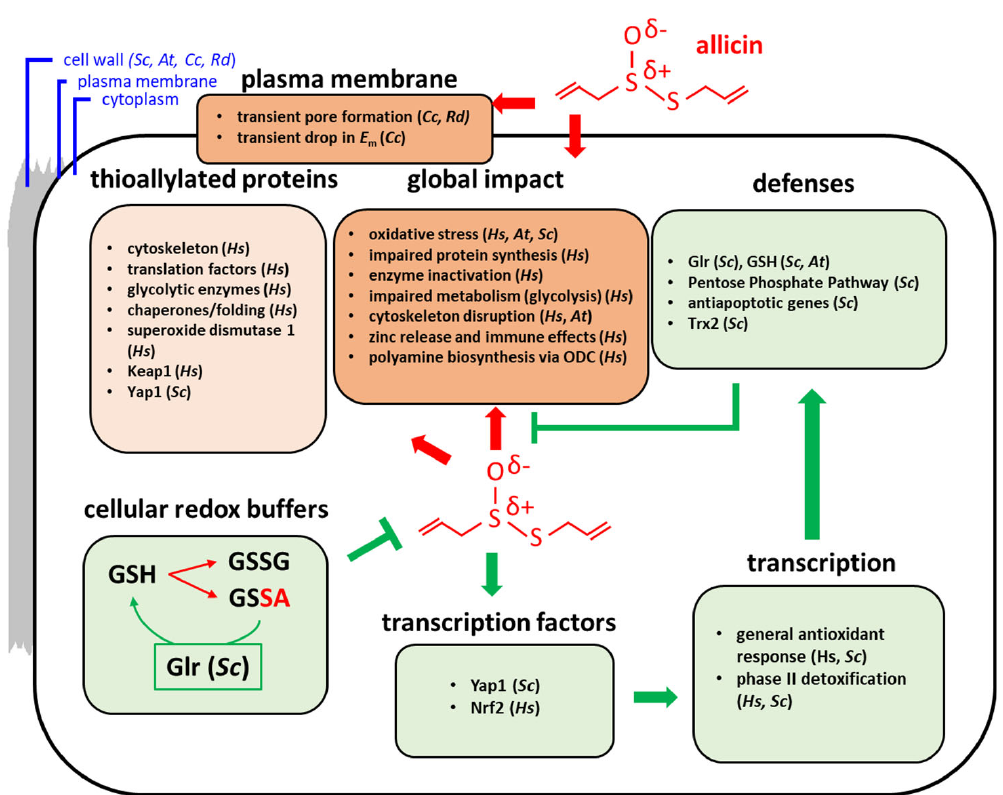
Figure 5. Summary of some of the effects of allicin on eukaryotic cells. Selected proteins are directly S ‐ thioallylated and their biochemical function is thus altered (in most cases inhibition). This manifests itself in a general oxidative stress response, changes in metabolism and the cytoskeleton, an altered immune response and an influence on polyamine metabolism. A direct influence on cell membrane integrity can also be observed. At the same time, cells also respond to allicin exposure, for example through redox ‐ sensitive transcription factors whose activity can be stimulated by allicin. Typical factors are the Nrf2 ‐ Keap1 system in mammals or the Yap1 transcription factor in yeast. These lead to the activation of protective mechanisms against oxidative stress. Various defense mechanisms are subsequently activated, with GSH synthesis being of particular importance. Associated with this is the Pentose Phosphate Pathway, in heterotrophic organisms the most important source of NADPH, the electron donor for glutathione reductase (Glr, GR). However, the expression of anti-apoptotic genes is also significant for protection against allicin, as is the phytohormone jasmonic acid in plants. Thioredoxins, especially Trx2, also seem to play a subordinate role, and their contribution is not as marked as that of the glutathione system. At = Arabidopsis thaliana , Cc = Chara corallina , Hs = Homo sapiens , Rd = Rhoeo discolor , Sc = Saccharomyces cerevisiae